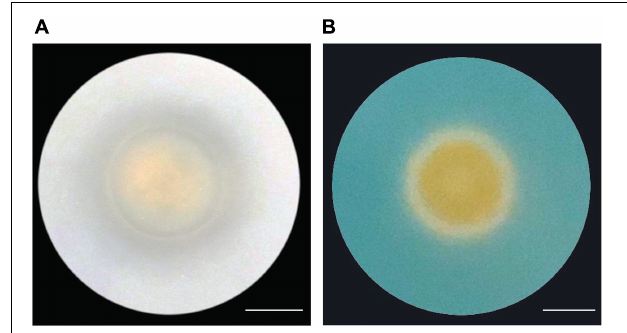
FIGURE 7 | Nutrient acquisition abilities by strain A4 (A) Phosphate solubilization by A4. Clear zone surrounding the bacterial colony represents solubilization of Ca 3 (PO 4 ) 2 . (B) Siderophore production in CAS medium. The color change from blue to yellow caused by siderophore production can be observed surrounding the bacterial colony. Scale bars = 10 mm.